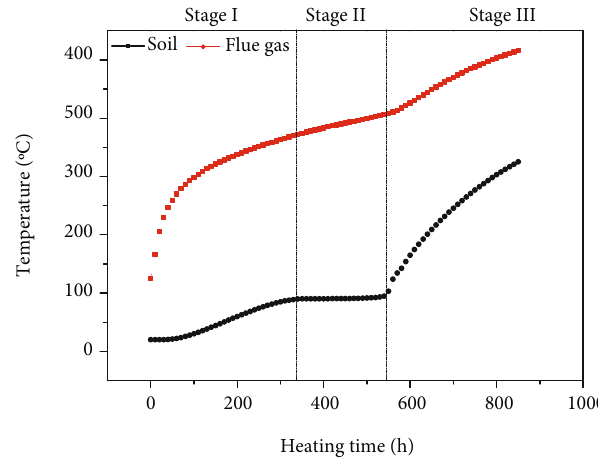
Figure 4: Variation of the temperature of the soil at the boundary and fl ue gas with heating